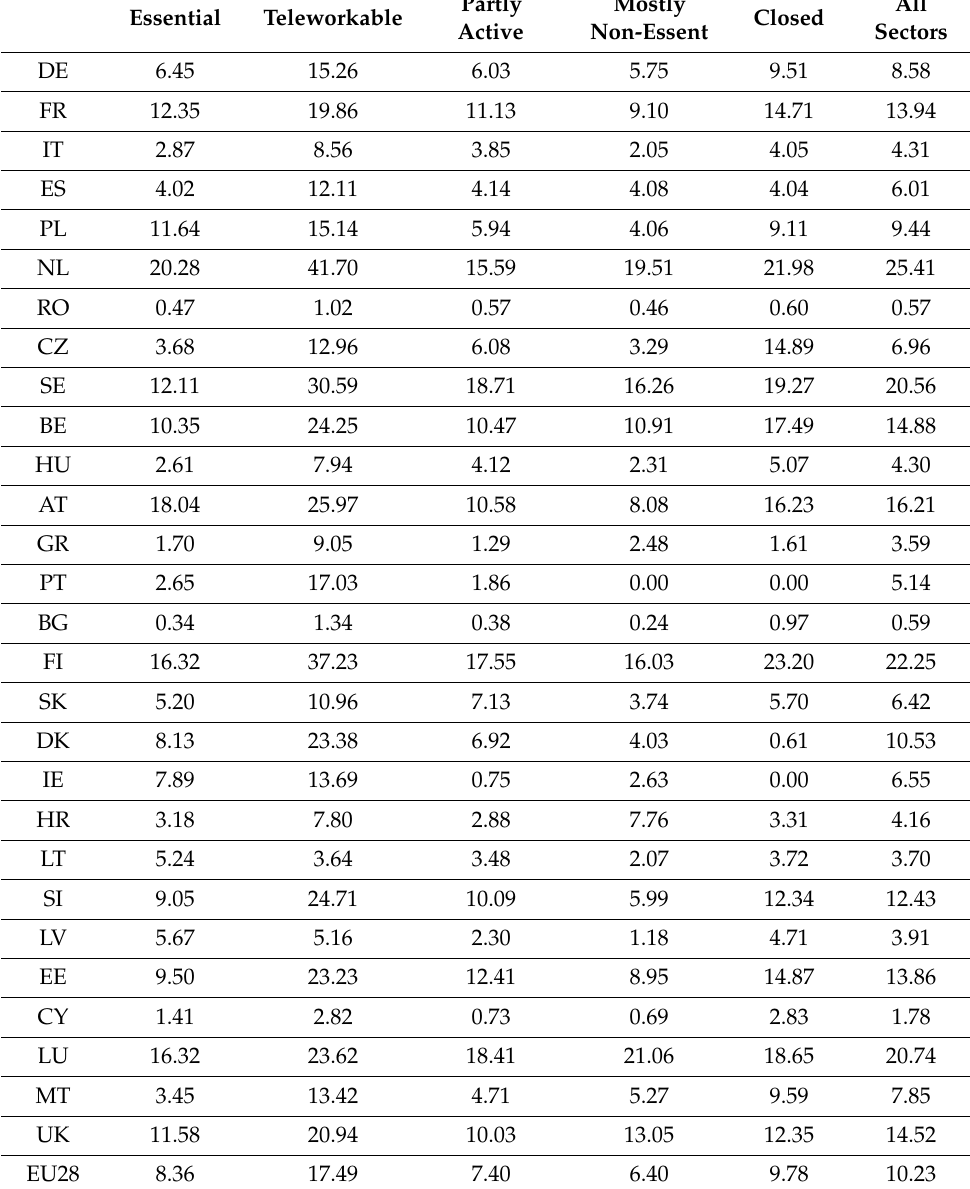
Table A1. Experience of telework pre-COVID crisis (index 0-100) in each of the